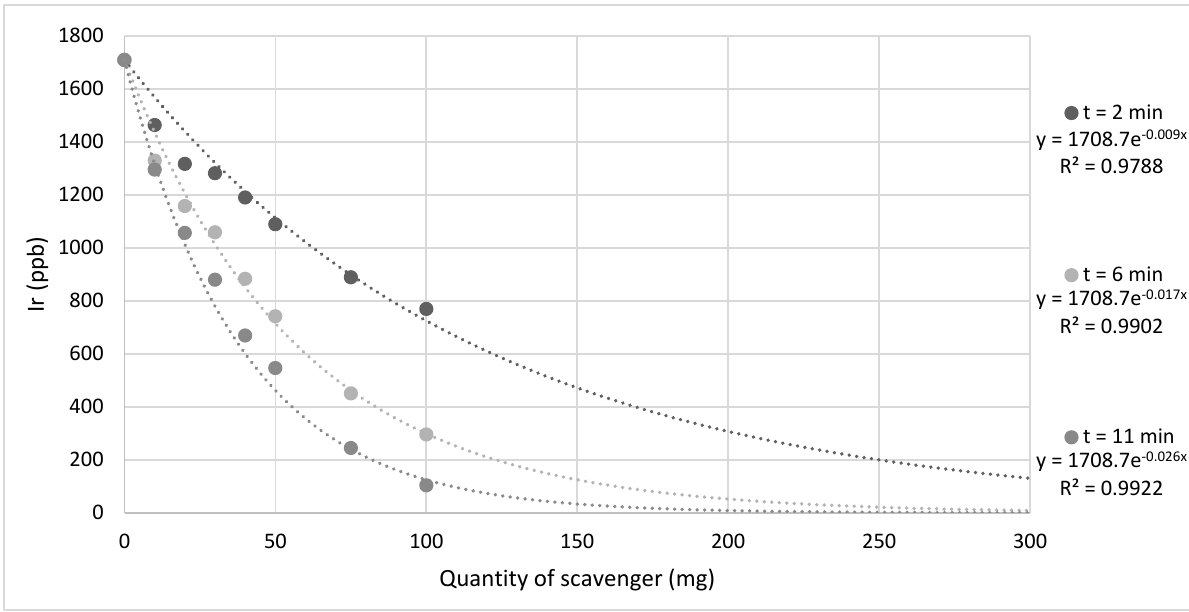
Figure 5. Amount of iridium present in samples following the addition of a variable amount of scavenger S 5 after t = 2 min, 6 min, and 11 min exposure time. The quantity of scavengers is extrapolated to demonstrate how much scavenger would be required for near-complete iridium removal.